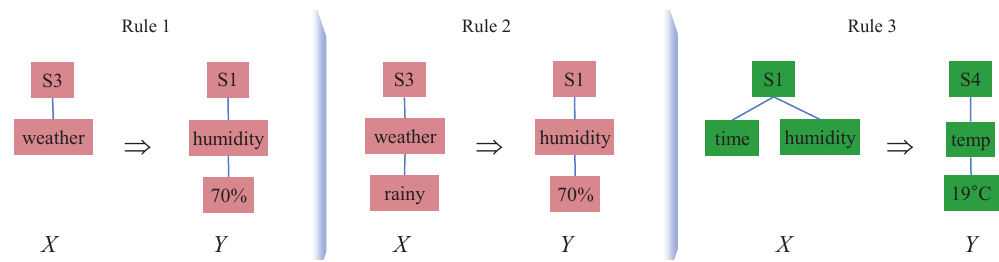
Figure 3. Association rule candidates configured with titems from the fractions of XSD in Figure